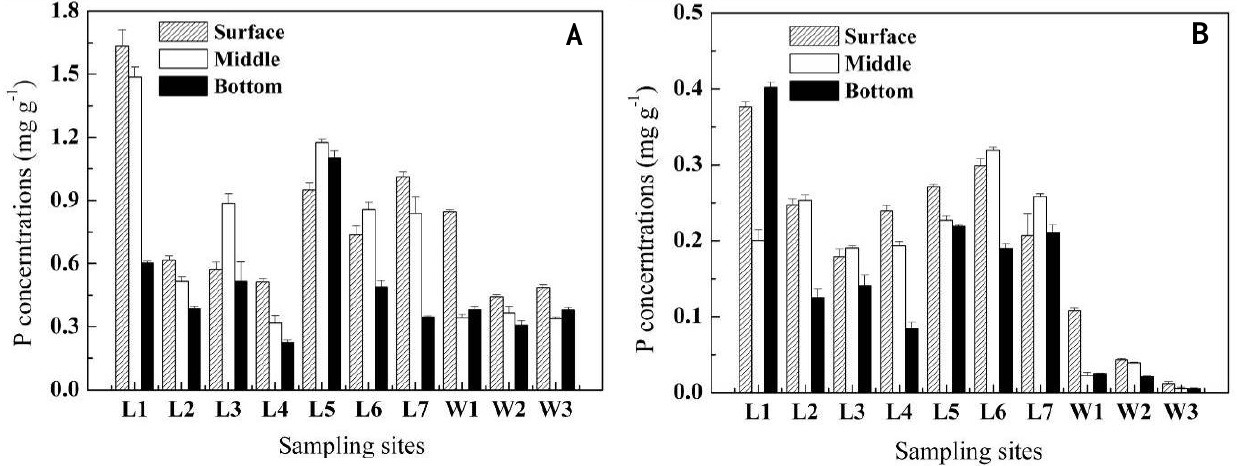
Figure 1. Vertical variations of concentrations of different P fractions and distribution of phosphate solubilizing bacteria in different sampling sites (A: TP; B: OP; C: NaOH-P; D: HCl-P; E: OPB B; F: